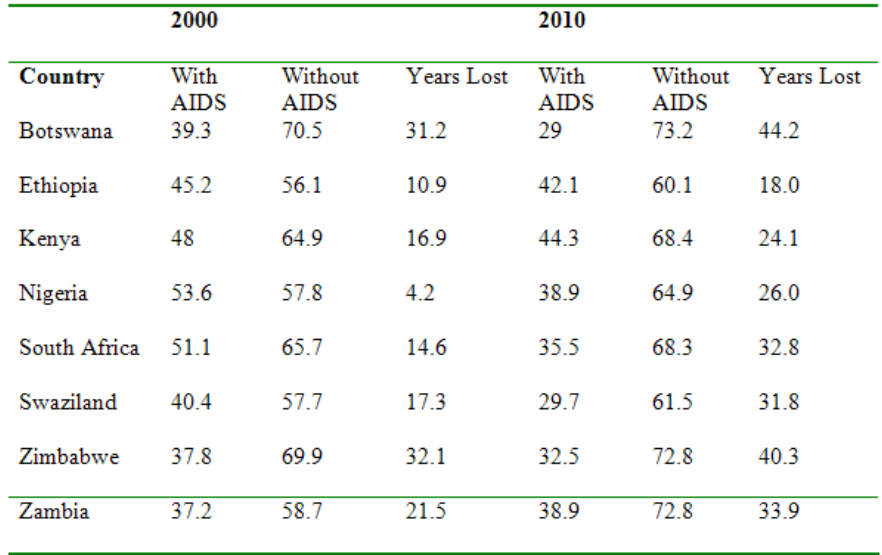
Table 3. Life expectancy with and without AIDS in selected African